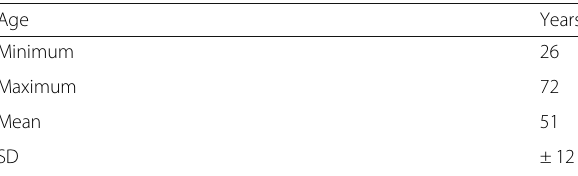
Table 2 Age distribution of the patients participating in the